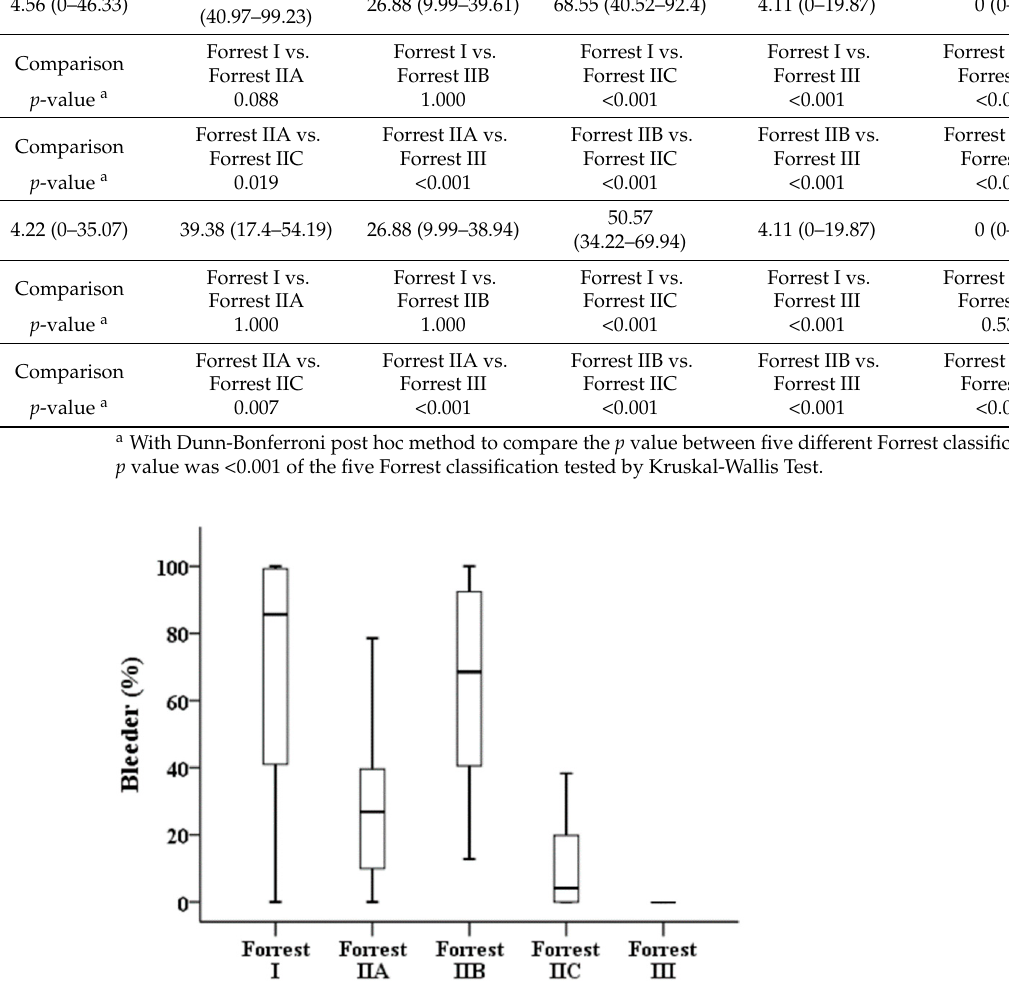
Table 3. Comparison of bleeder patterns among different Forrest classes of the endoscopy images.